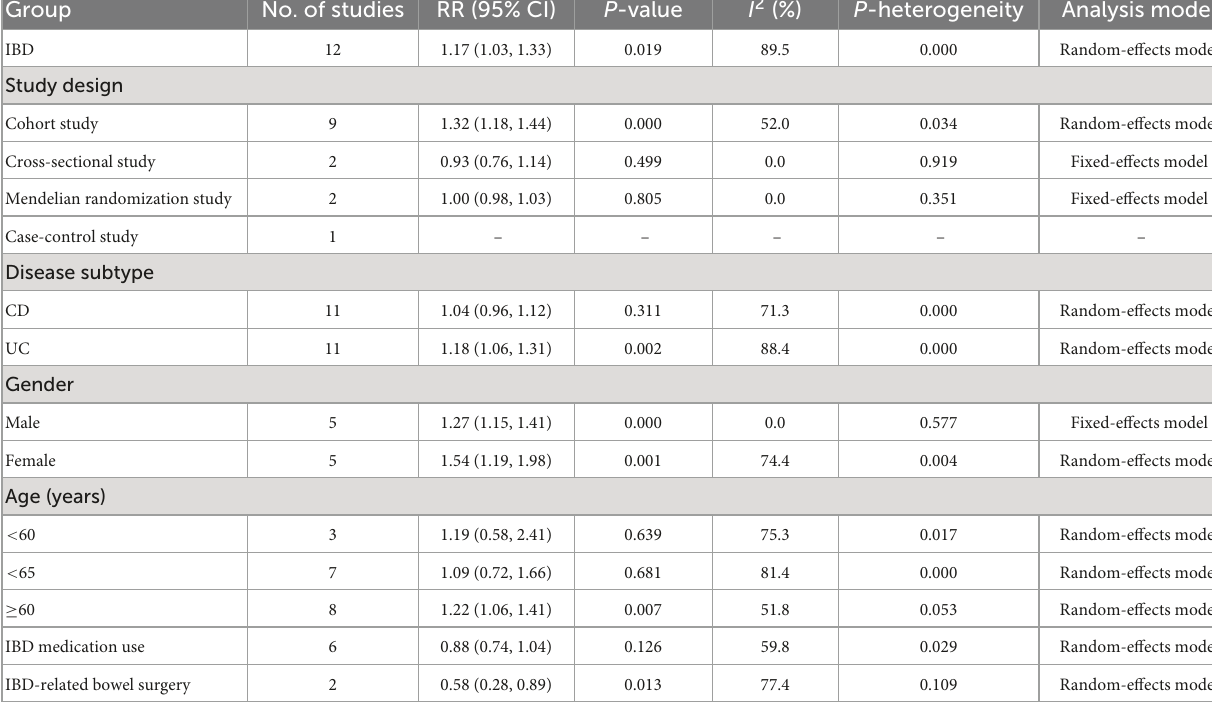
TABLE 2 Results of meta-analysis for inflammatory bowel disease and the risk of Parkinson’s disease. Group